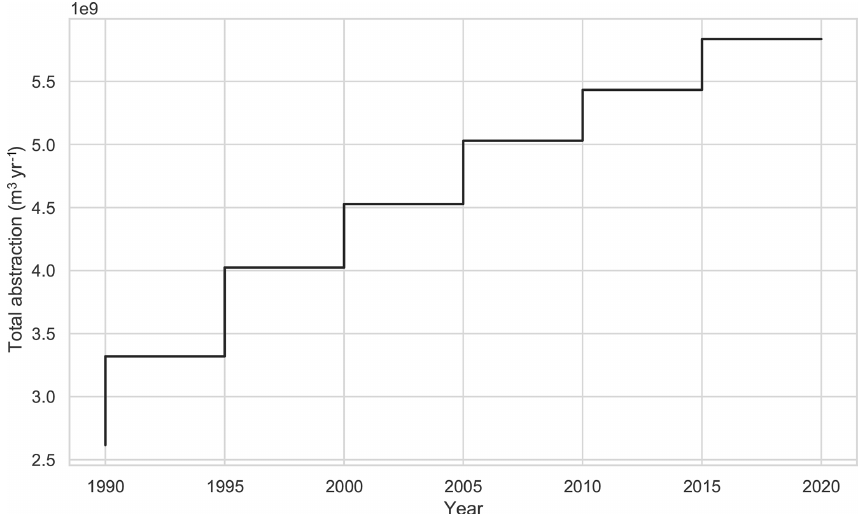
Figure A2. Total annual abstraction used as model input for the last 30 years of the simulation. This period has stress periods of 5 years.